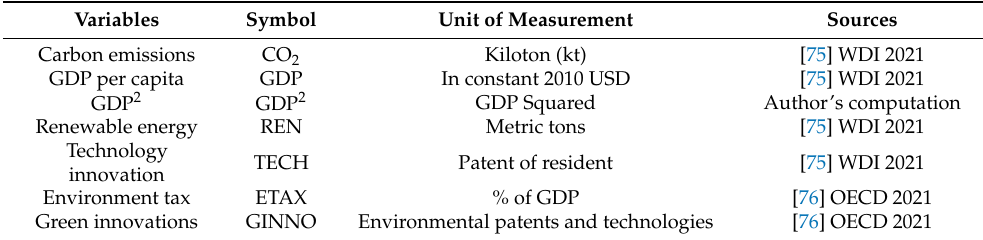
Figure 3. Geographical coverage of E7 nations. Table 2. Description of